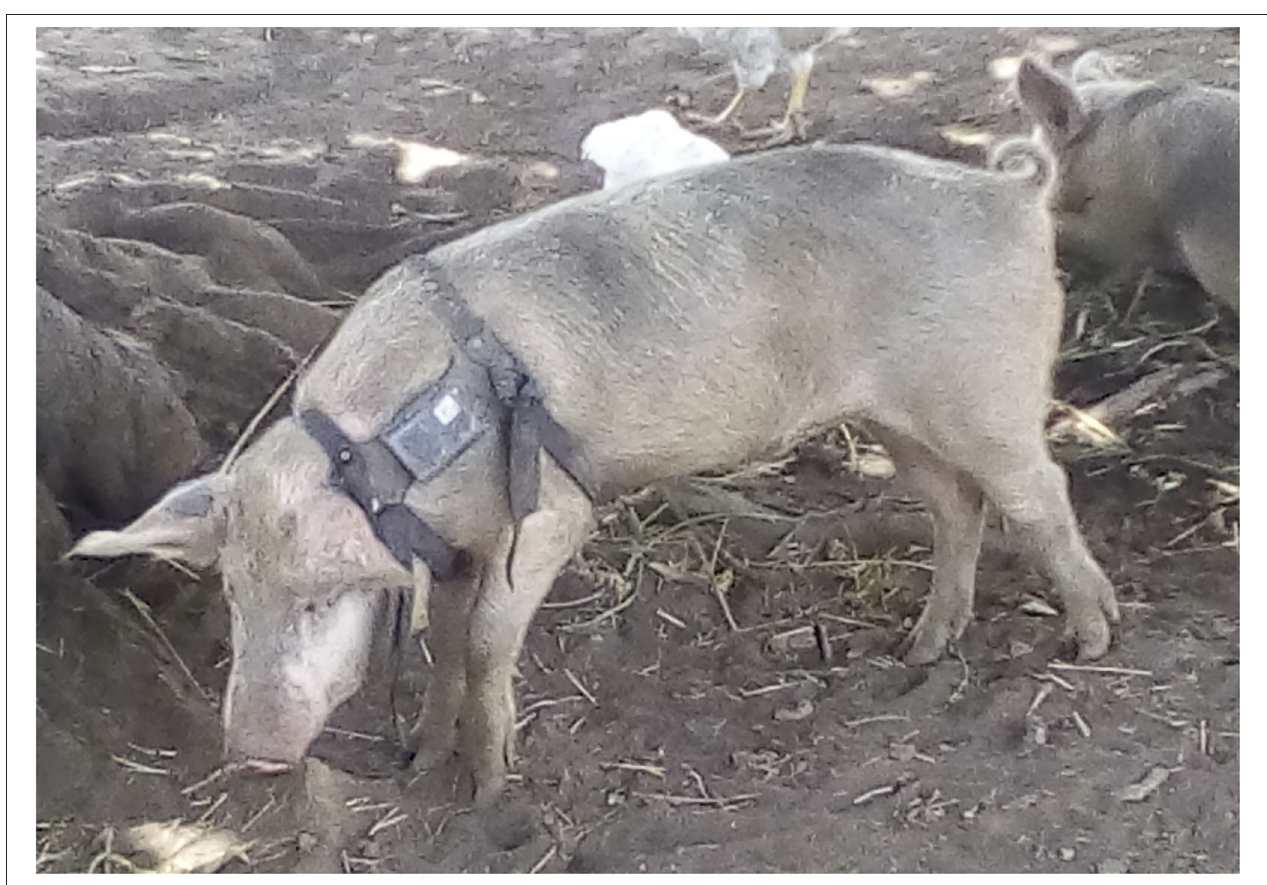
FIGURE 2 | Domestic pig fitted with a GPS-GSM harness (Savannah Tracking, Ltd., Nairobi,